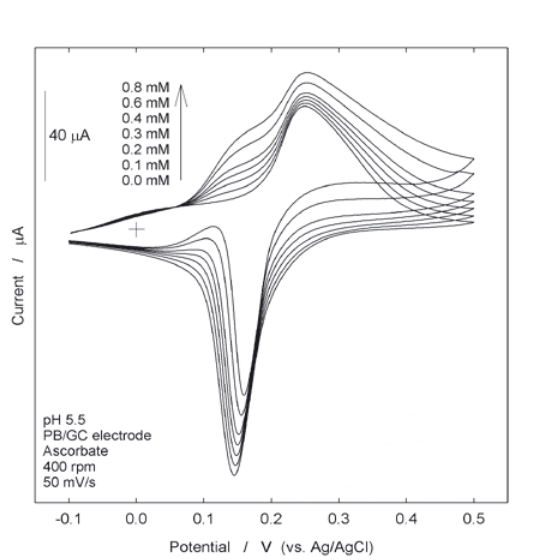
Figure 2. Cyclic voltammograms of Prussian blue modified glassy carbon rotating disk electrode, as obtained within potential scan limits of -0.1 to 0.5 V at potential sweep rate of 100 mV s -1 , and at rotating velocity of 400 rpm in pH 5.5 solution containing different concentrations of ascorbate ranging from 0.0 to 0.8 mM (as indicated). An inset shows cyclic voltammogram for high concentration (3.0 mM) of